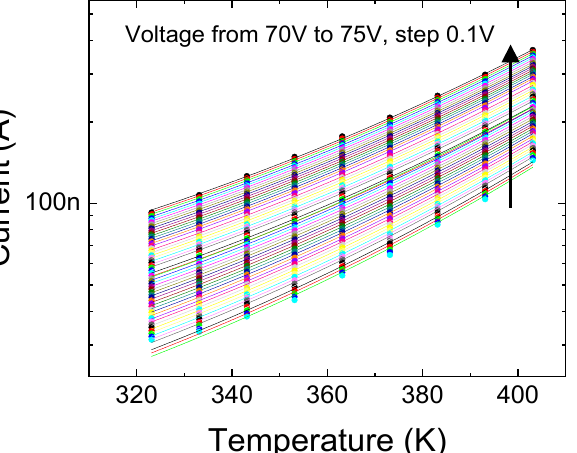
Figure 6. Modeling reverse leakage diode behavior using variable range hopping (VRH) from V= − 70 V to − 75 V (Region 2) for T = 50 °C (323 K) to 130 °C (403 K). I 0 modifies the trap emission rate into current, C VRH represents a grouped constant, (cid:2870) (cid:3435)𝑞𝑎 = 4.626 (cid:3400) 10 (cid:2879)(cid:2871) (cid:3400) 𝑈(cid:3415) (cid:3439) which can be written as 𝐶 [7], where q is the elementary (cid:3023)(cid:3019)(cid:3009)